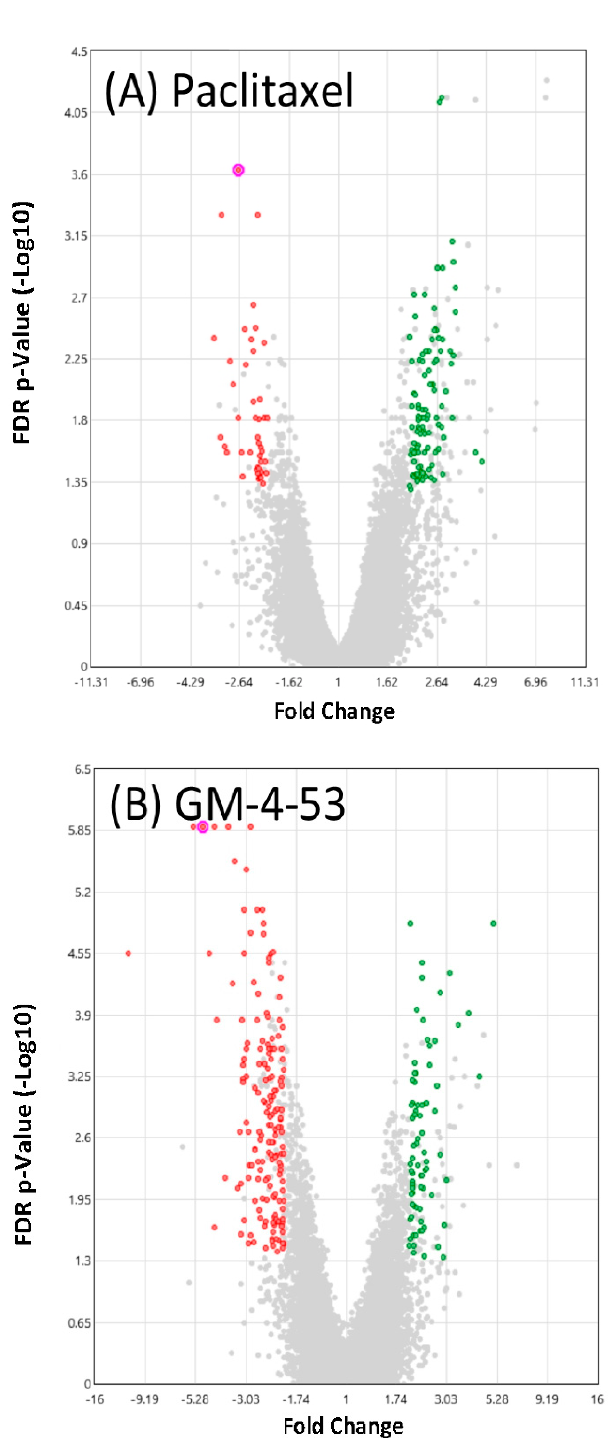
Figure 4. Summary of gene changes by fold change and significance in cytostatic cells vs. untreated controls from a total of 48,226 genes analyzed. ( A ) paclitaxel (1 µg/mL) vs. controls ( B ) GM 4-53 (5 µg/mL) in MDA-MB-231. The data show upregulated DEGs (right/green) and downregulated DEGs (left/red) by fold change relative to untreated controls ( X -axis), with FDR p -values ( Y -axis). Selected criteria for array analysis: Fold change >2 or < − 2, p -value < 0.05, and false discovery rate (FDR) p -value < 0.05. Plotted points denoted in gray did not meet the selected criteria.